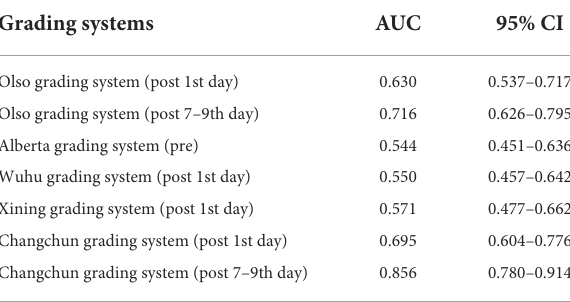
TABLE 6 Comparison of the different grading systems (n =